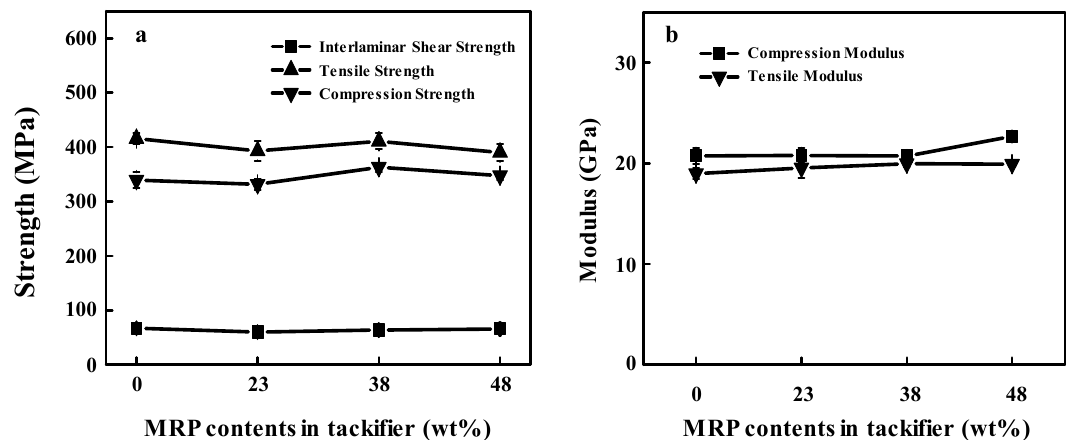
Figure 9. Mechanical properties of RTM epoxy composites. ( a ) Interlaminar shear, tensile, and compression strength values of RTM epoxy composites preformed by ET3228 tackifiers with an MRP content in the range of 0 to 48 wt.%. ( b ) Tensile and compression modulus values of RTM epoxy composites preformed by ET3228 tackifiers with an MRP content in the range of 0 to 48 wt.%. All the t -tests on the interlaminar shear, tensile, and compression strengths of composites resulted in a p value less than 0.05, indicating that the dependences of interlaminar shear, tensile and compression strength on MRP content are statistically significant. The t -test on the moduli of composites resulted in a p value larger than 0.05, indicating that the dependences of tensile and compression moduli on MRP content are not statistically significant.